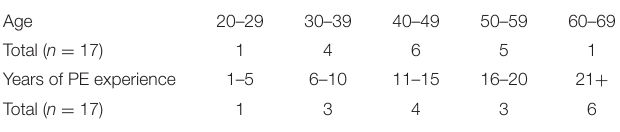
TABLE 3 | Participants’ ages and years of PE teaching